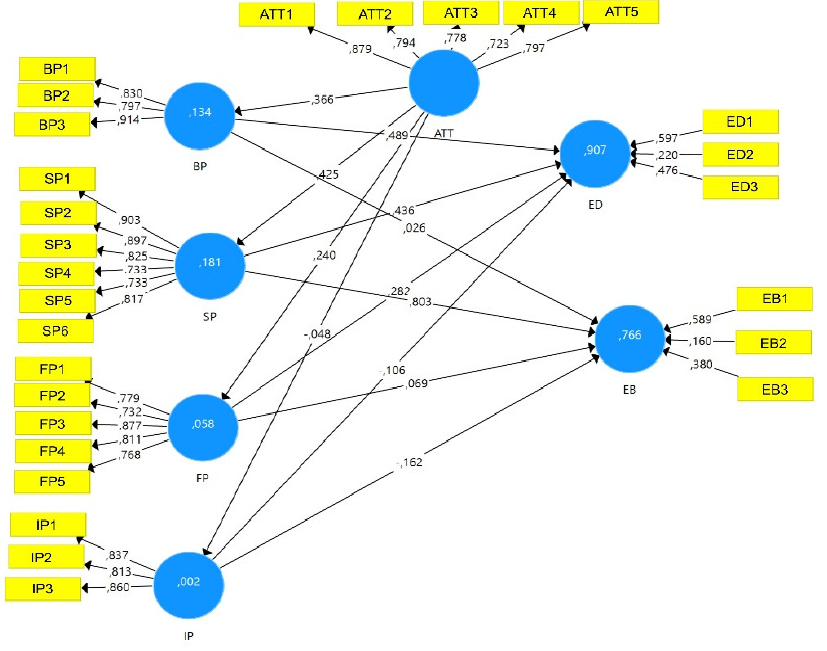
Figure 2. Complete final models.